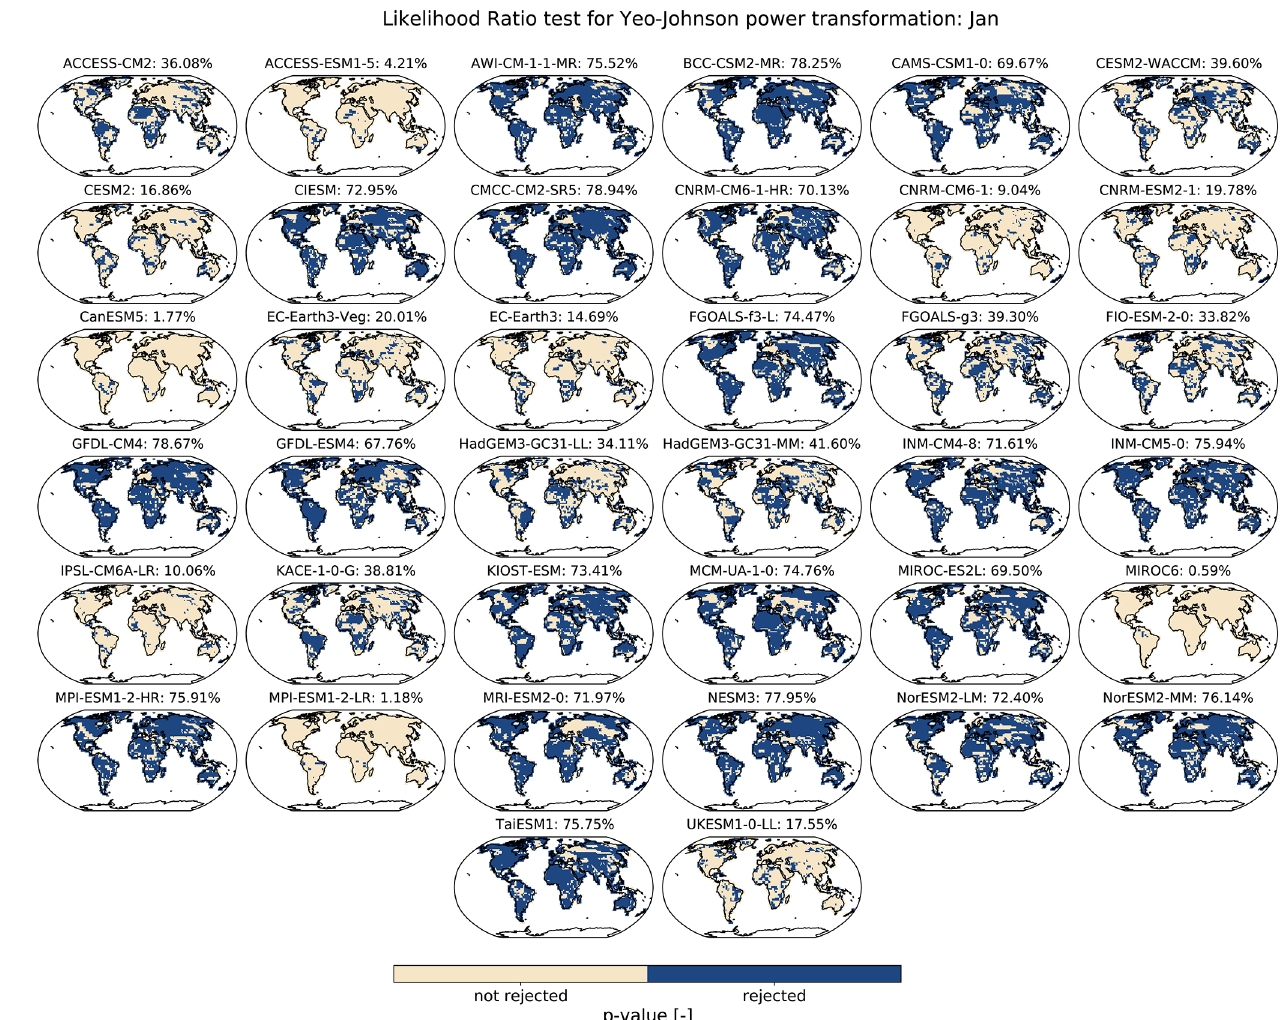
Figure C1. Likelihood ratio test comparing the performance of January’s Yeo–Johnson transformations when using just one single lambda parameter ( λ m,s ) vs. when using a yearly temperature-dependent lambda parameter ( λ y,m,s ). The null hypothesis is that the λ m,s -based trans- formation performs better than the λ y,m,s -based transformation. A Benjamini–Hochberg multiple test correction (Benjamini and Hochberg, 1995) is applied to the p values before plotting them. Percentage values indicate the proportion of grid points for which the null hypothesis is rejected.